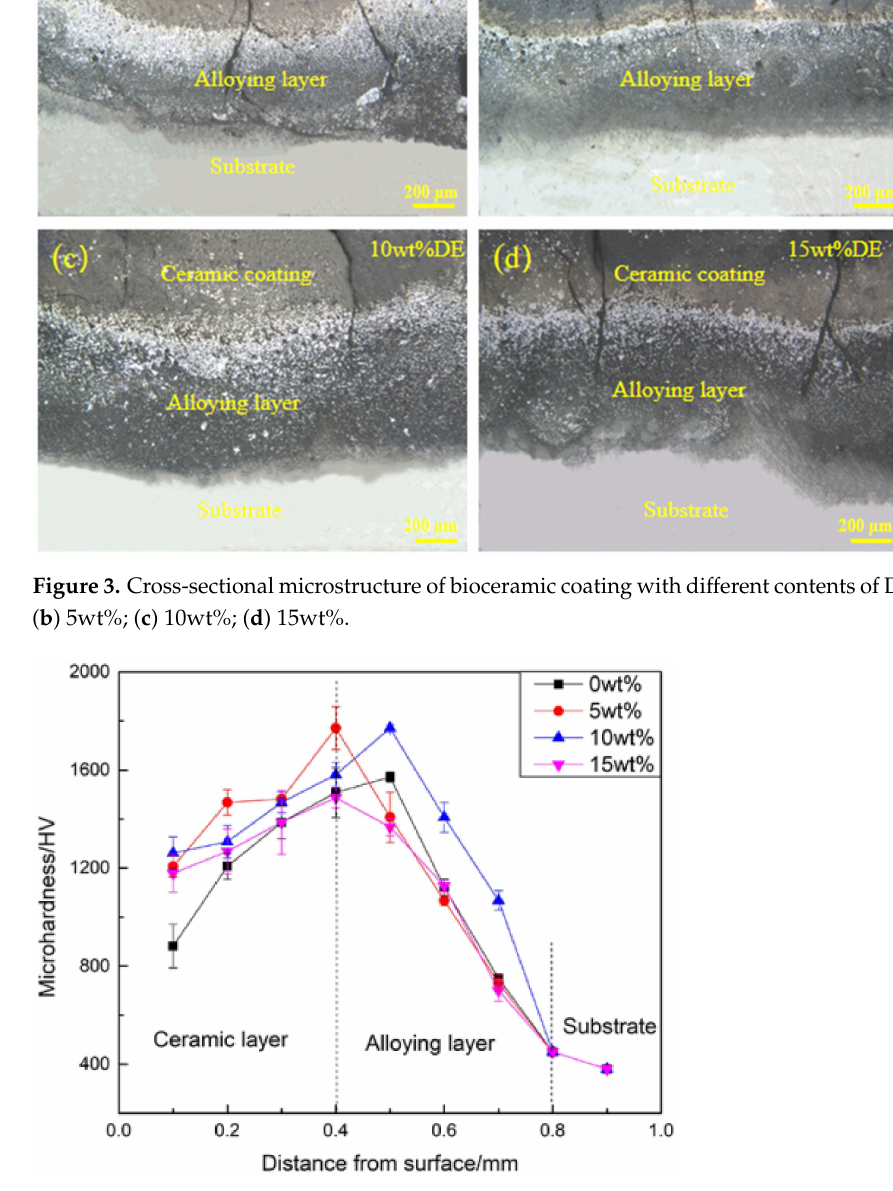
Figure 4. Microhardness analysis of bioceramic coating with different contents of DE (0wt%, 5wt%, 10wt% and